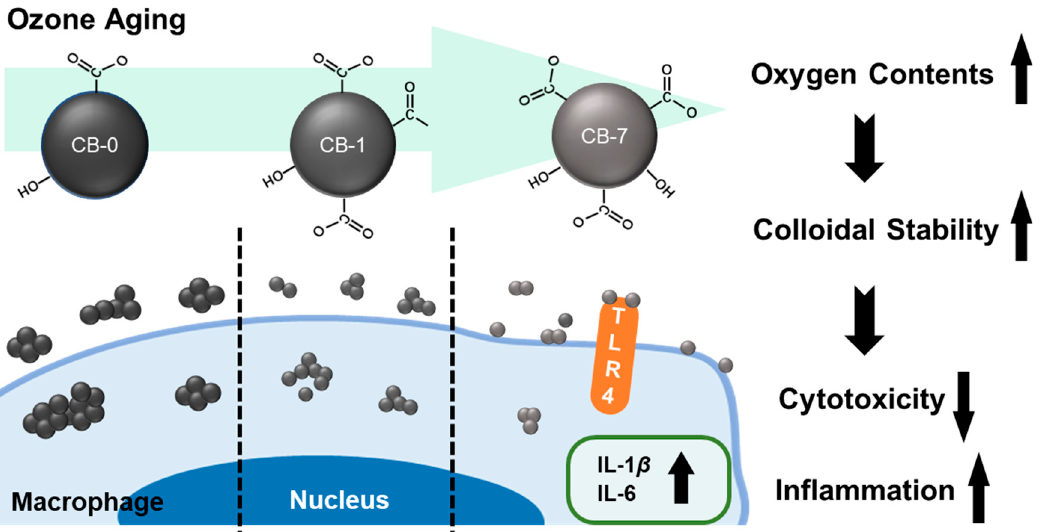
Figure 7. A schematic diagram illustrating the ageing process in altering the cytotoxicity profiles of CB particles in macrophages. Abbreviations: CB: carbon black; IL, interleukin; TLR4, toll-like receptor 4.